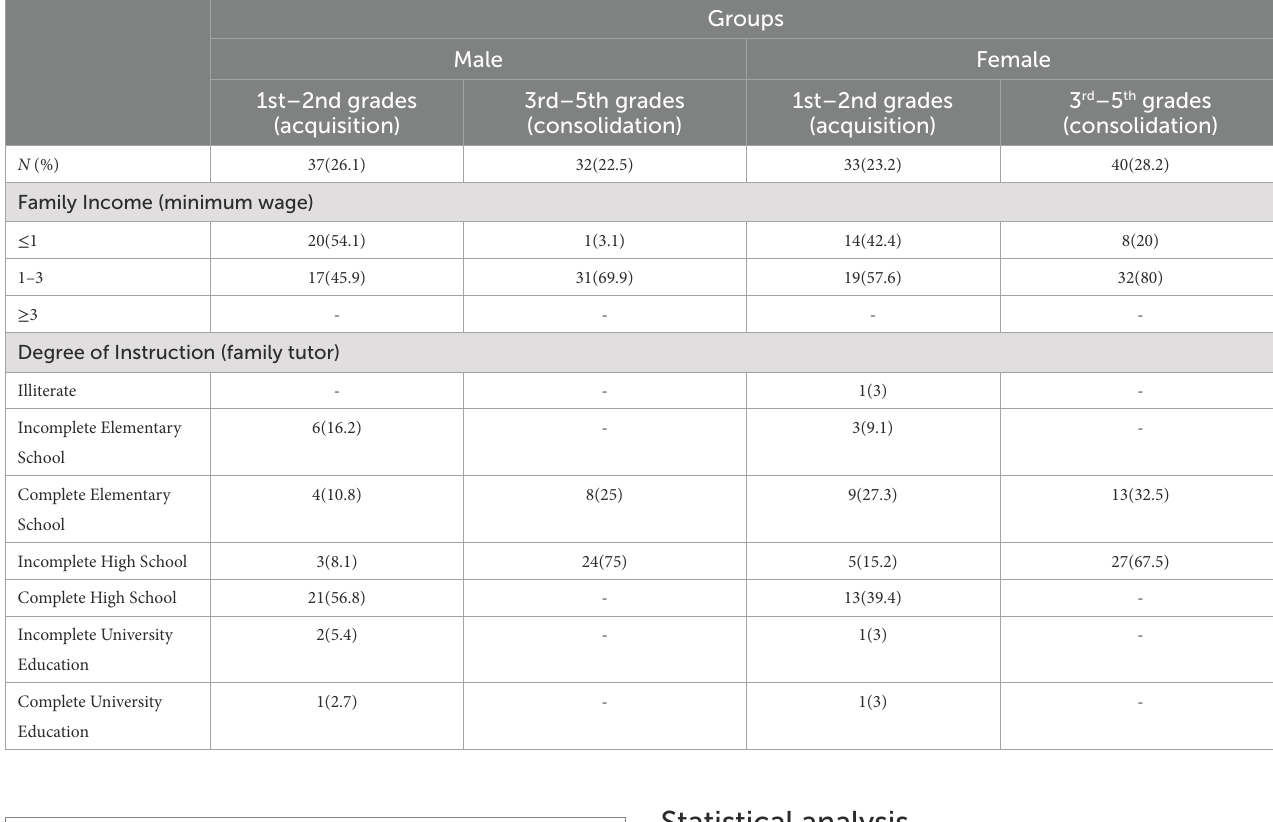
TABLE 1 Socio-demographic profile of subjects.